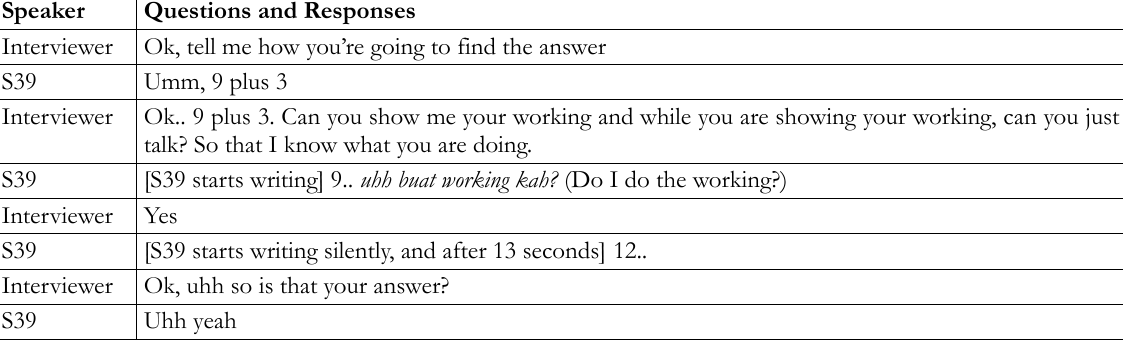
Table 8. Interview excerpts from student S39